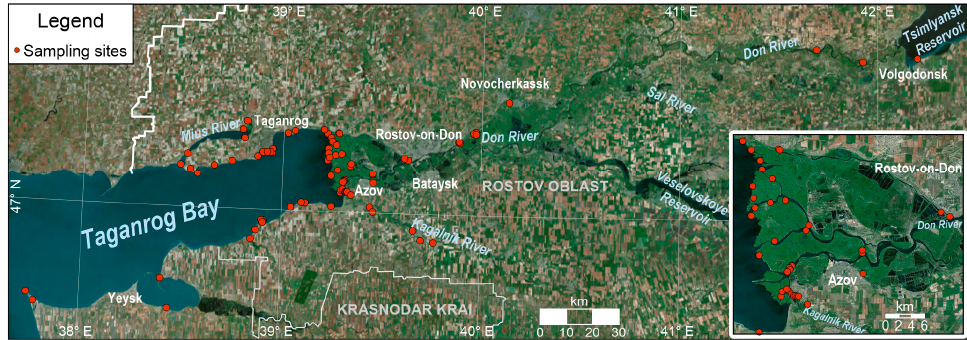
Figure 1. Location of the study area and soil sampling sites (red dots). The satellite image was from Google Earth.